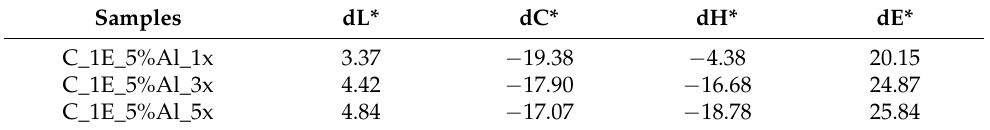
Table 10. Change in color coordinates of cotton samples dyed with SJL aqueous extract with 5% Al mordants after 1st, 3rd and 5th washing cycle (compared with C_1E_5%Al_0x).